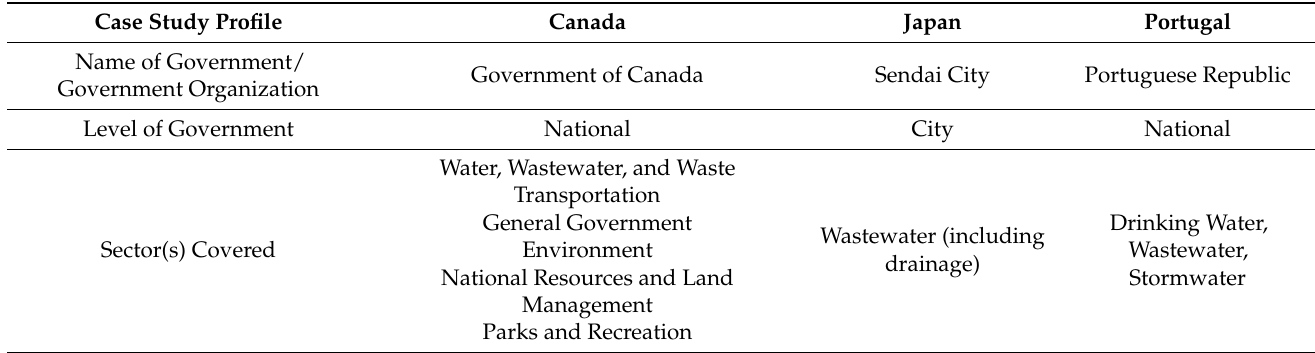
Table 1. Summary profile of case studies included for evaluation.